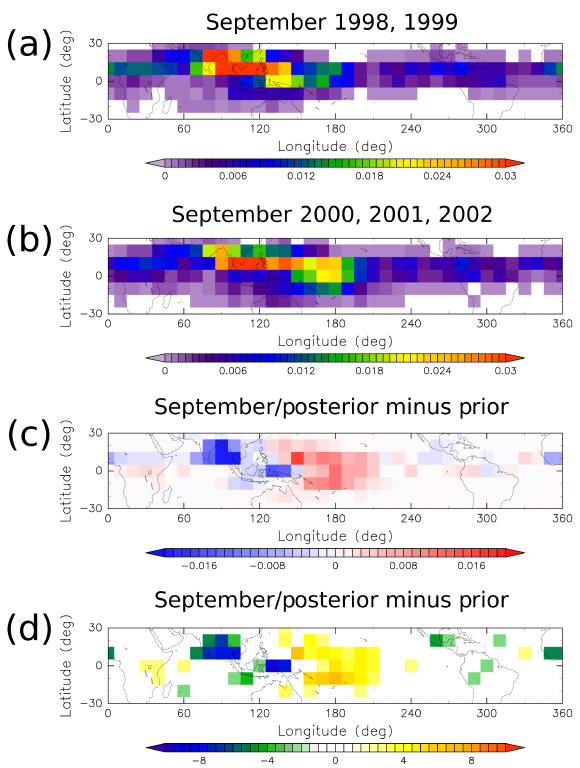
Figure 5. Horizontal distribution of LCP-event probability, P( LCP ∈ j) , estimated from the TST trajectories initialized at 400K in (a) September 1998 and 1999 (prior to the drop) and (b) September 2000, 2001, and 2002 (posterior to the drop). The probabilities are estimated in 10 ◦ by 10 ◦ longitude–latitude bin as the number of LCPs experienced by all TST air parcels inside the bin divided by the total number of TST parcels used for the cal- culation ( N( LCP ∈ j)/N TST ). Panels (c) and (d) are the difference of probabilities between the two (posterior minus prior to the drop) and the values of test statistic ( T 1 of Appendix A1), respectively. The colored bins indicate that the difference is statistically signif- icant at the significance level of 1% or higher. Those bins shown in white indicate that no LCP event is found in (a) and (b) , while the difference is not statistically significant in (c) and (d) . See Ap- pendix A for the details of statistical